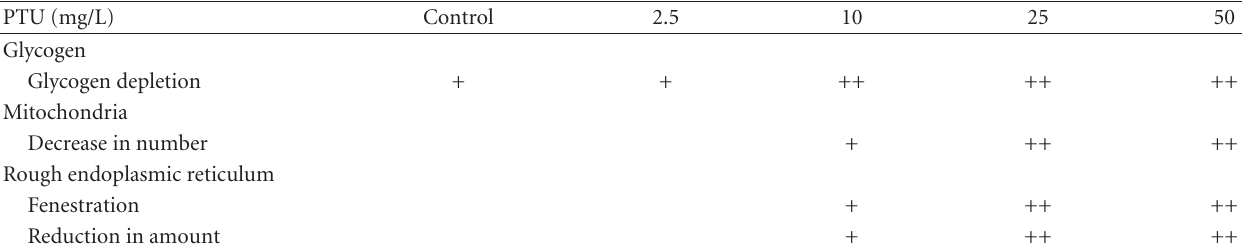
Table 3: Semiquantitative evaluation of alterations in the liver of zebrafish ( Danio rerio ) induced by PTU.